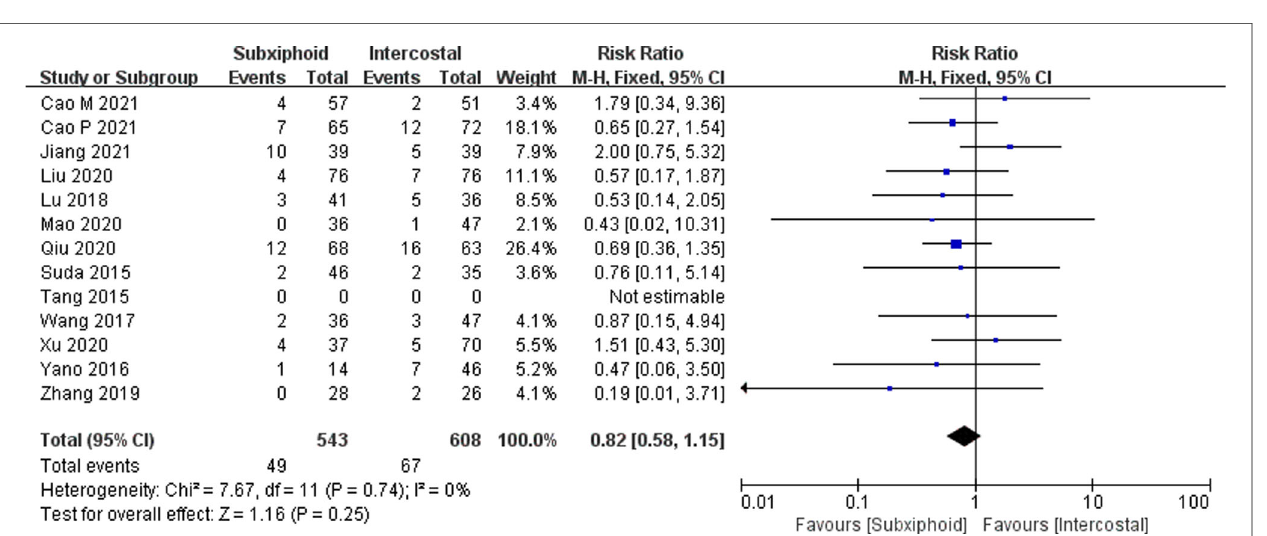
FIGURE 12 | Forest plot of the role of RR and its 95% CI of interoperative and postoperative complications between SVATS and IVATS